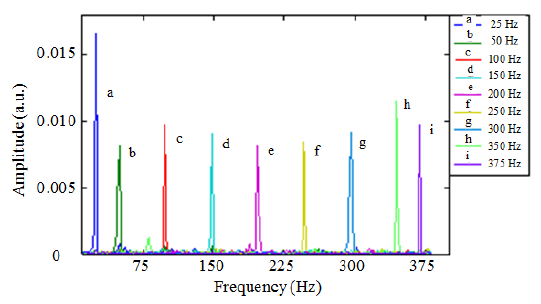
Fig. 5 Auto-power spectrum in different vibration frequencies at the location of 97.51 km.